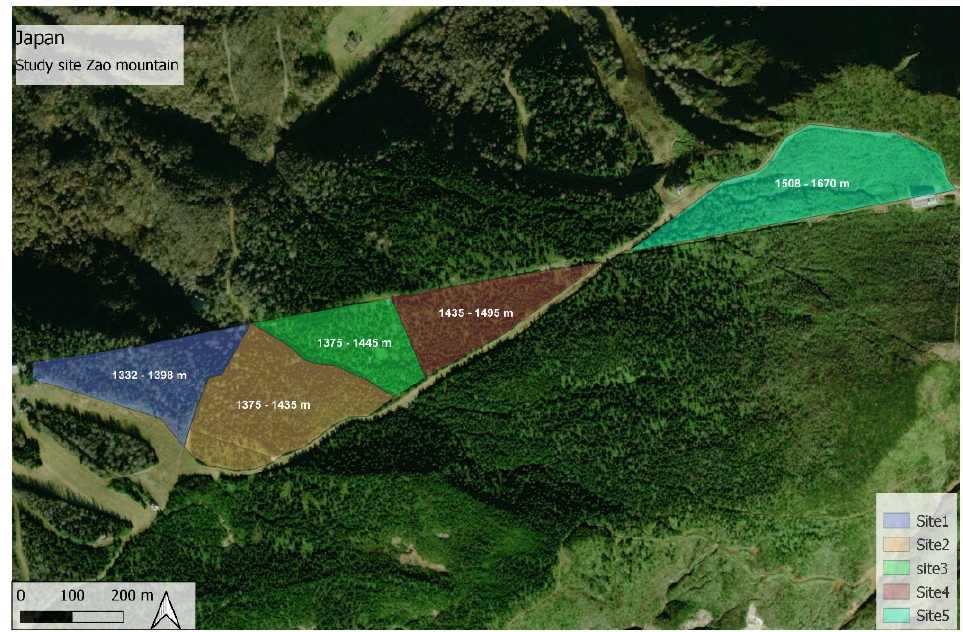
Figure 1. Study area in Zao Mountains with the five sites, ranging from 1360 to 1660 m.a.s.l. in southeastern Yamagata, Japan.